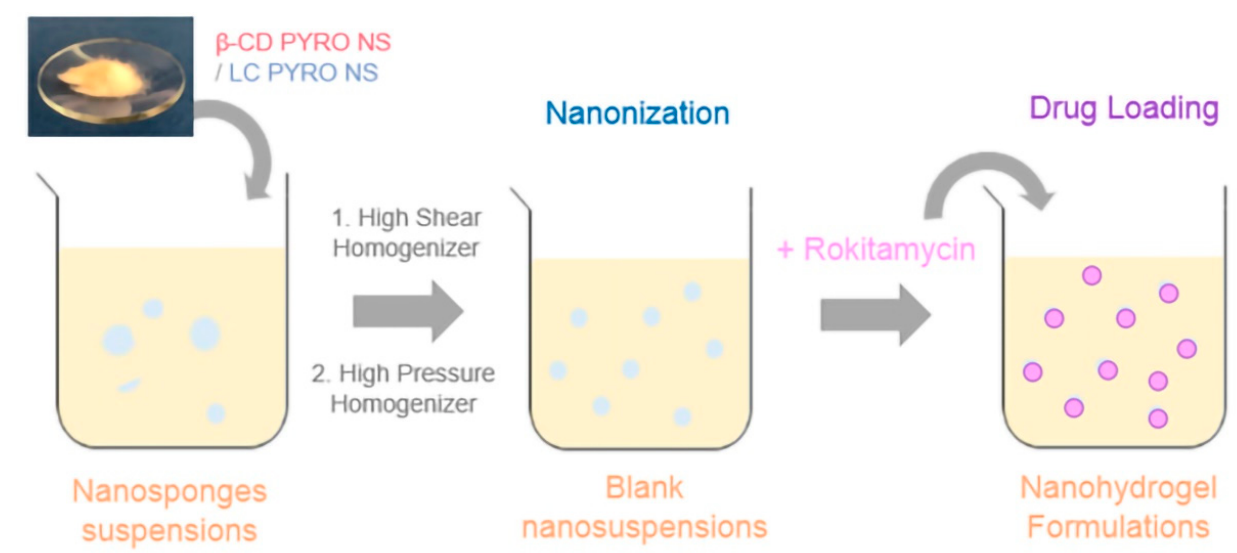
Figure 4. Schematic representation of the nanohydrogel formulation.